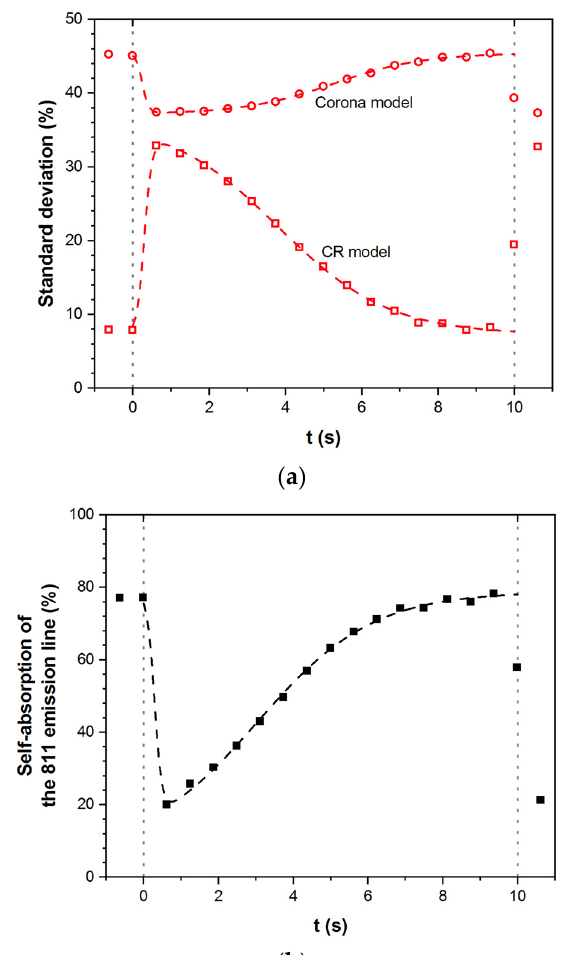
Figure 7. ( a ) Evolution of the percentage standard deviation over an injection period for the standard CR and Corona models (red curves). ( b ) Evolution of the self-absorption percentage of the Ar 811 nm emission line according to the standard CR model (black curve).